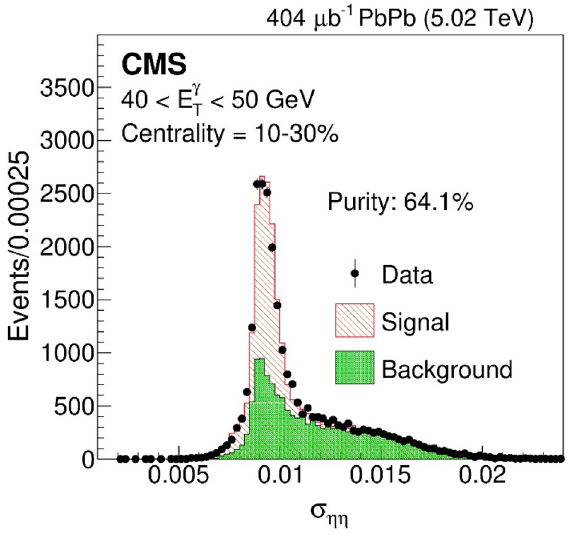
Figure 1 . Template (cid:12)t of the shower shape variable (cid:27) for 40 < E g < 50 GeV in the 10{30% (cid:17)(cid:17) T centrality class. The black points show the PbPb experimental data. The red histogram is the signal template obtained from pythia + hydjet simulations, and the green histogram is the background template estimated from the data for the nonisolated sideband region. Purity values are estimated in the range of (cid:27) < 0 : 01. (cid:17)(cid:17) respectively. The total e(cid:14)ciency is obtained by multiplying signal selection, trigger,